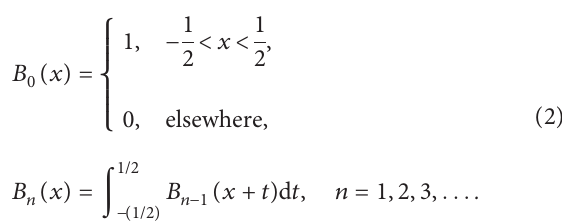
Figure 2: The graph of B